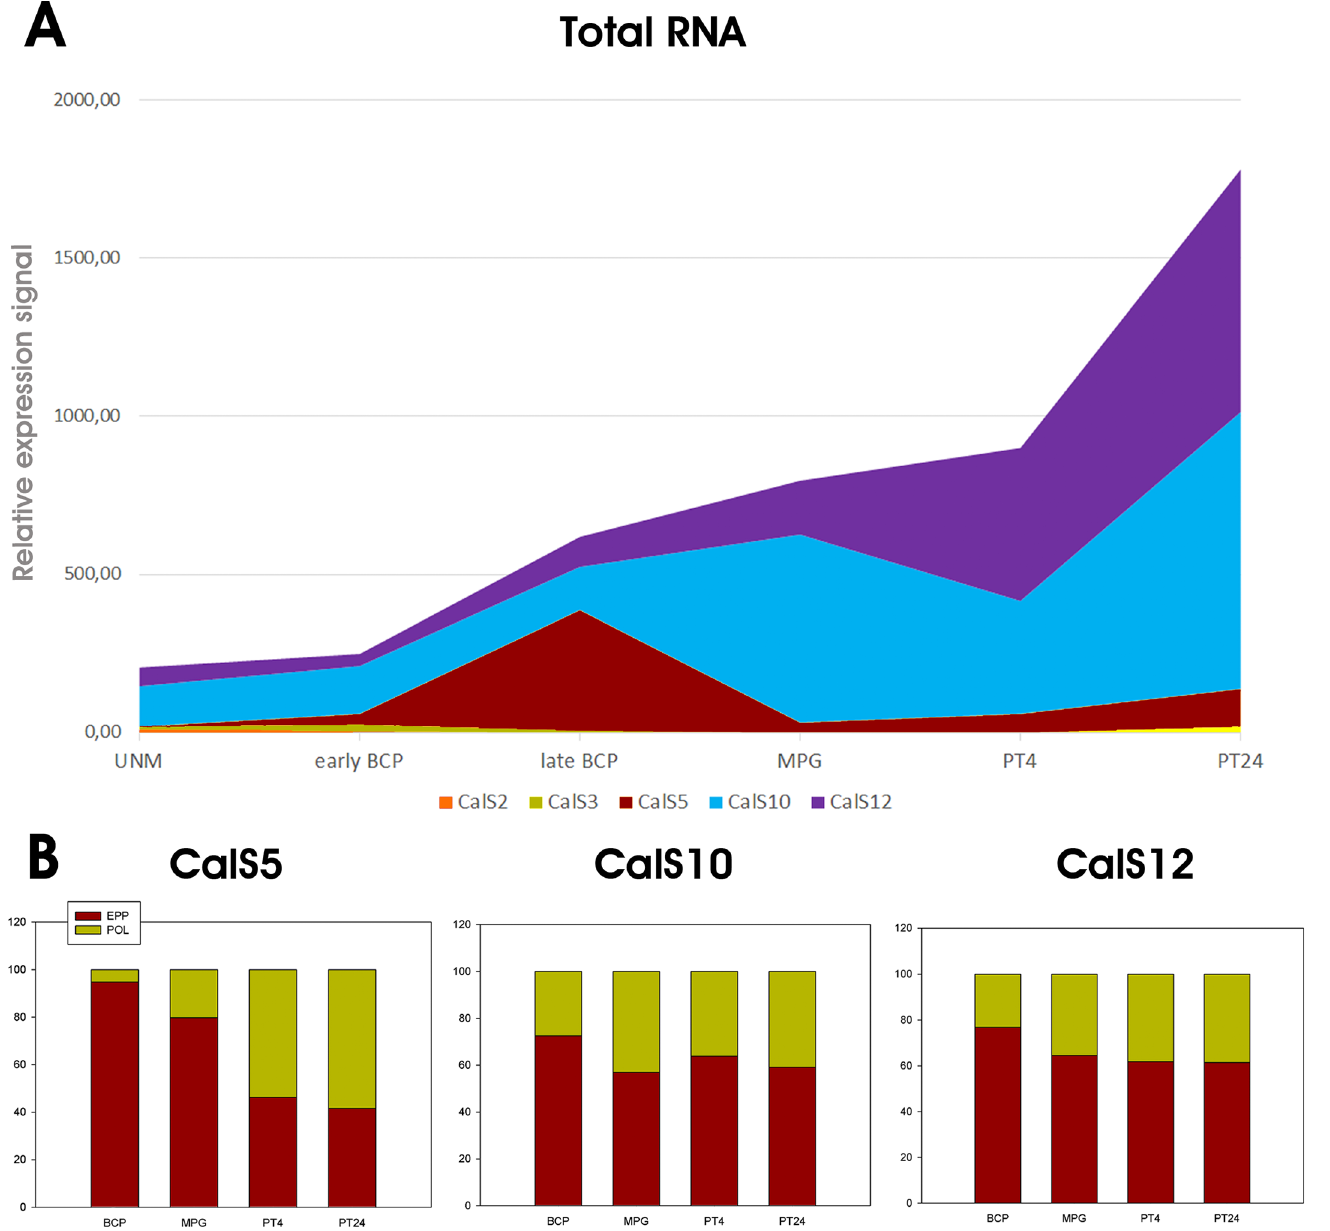
Fig 4. Callose synthase expression profiles in Nicotiana tabacum male gametophyte. A) Expression profile of five male gametophyte-expressed CalS mRNAs duringpollendevelopment and progamic phase, B) Distributionof transcripts encodingthree most abundanttobacco pollenCalS mRNAs (CalS5, CalS10,CalS12)between actively translated polysomal and storage EPP fractions. UNM, uninuclearmicrospore; early BCP, early bicellularpollen; late BCP, late bicellularpollen; MPG, mature pollengrain; PT4, 4h pollentubes; PT24, 24h pollentubes; EPP, mRNA storage EPP complexes; POL,